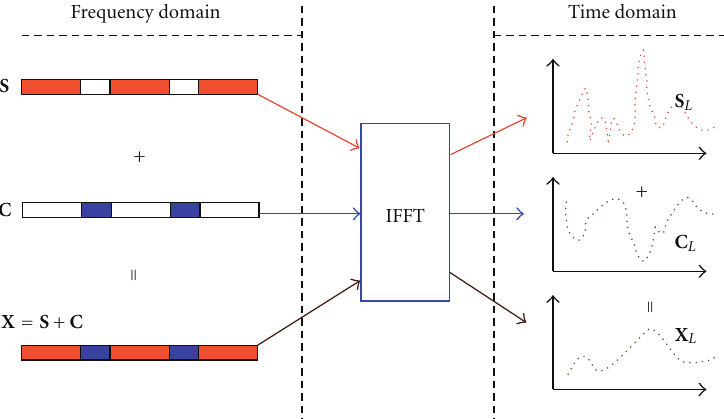
Figure 1: Pilots insertion scheme.